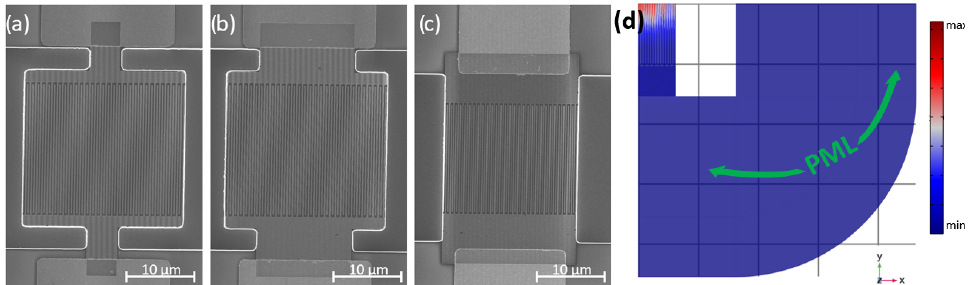
Figure 14. SEM micrographs and admittance responses of the three devices with different anchors: ( a ) SEM of CLMR with narrow anchor. ( b ) SEM of CLMR with medium anchors.( c ) SEM of CLMR with wide anchors. ( d ) Total displacement amplitude at resonance frequency of fully anchored CLMR simulated in COMSOL®3D